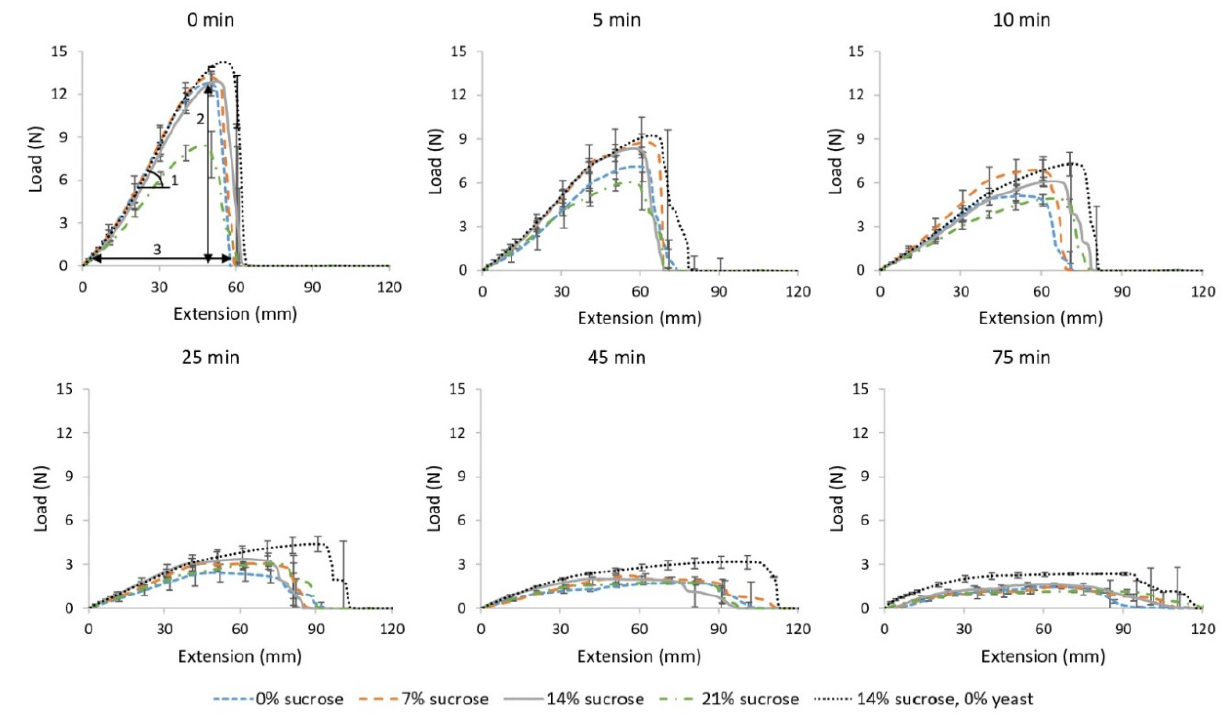
Figure 7. Evolution of dough rheology of laminated samples with 8% yeast and 0, 7, 14 and 21% sucrose and samples with 0% yeast and 14% sucrose during incubation at 30 °C and 80% relative humidity. Samples were taken before (0 min) and during (5–75 min) incubation. Load (N) is expressed in function of extension (mm). The slope of the linear part (1) represents dough elasticity (N/mm), the maximum height (2) represents dough strength (N) and the maximum width (3) represents dough extensibility (mm). Table 1. The individual calculated sweetness contributions (S A = kC n ) of glucose, fructose, sucrose, raffinose and maltose and the sweetness factor (S = S A + S B + . . . ) for pastry samples with 8% yeast and 0, 7, 14 and 21% sucrose (% w / w dm flour base) and samples with 0% yeast and 14% sucrose. The standard deviations result from duplicate